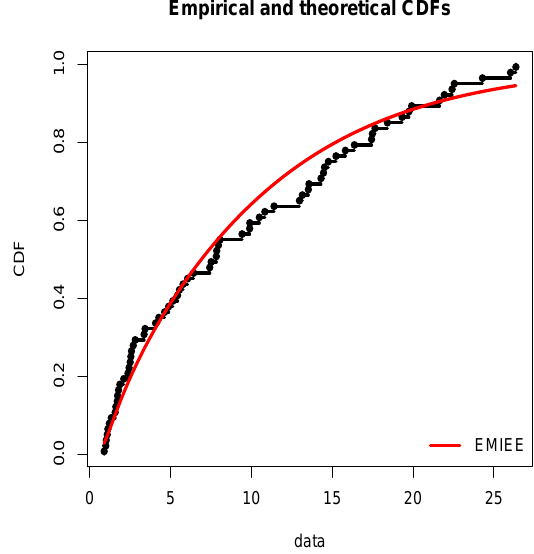
Figure 5. Estimated cdf of the EMIEE model over the histogram for the COVID-19